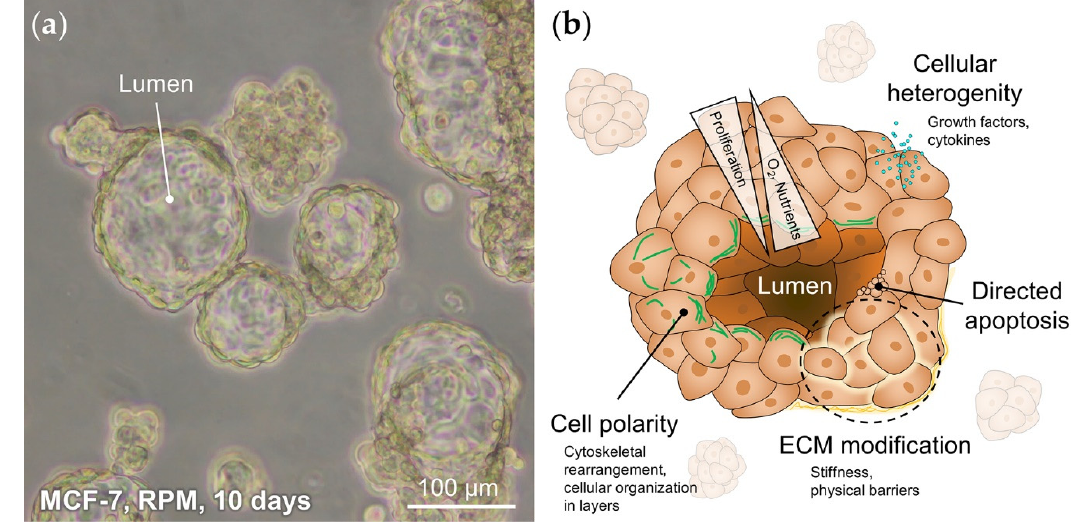
Figure 3. ( a ) Glandular MCF-7 spheroids grown in s-µ g for 10 days. ( b ) Schematic diagram and special features of a glandular breast cancer spheroid.